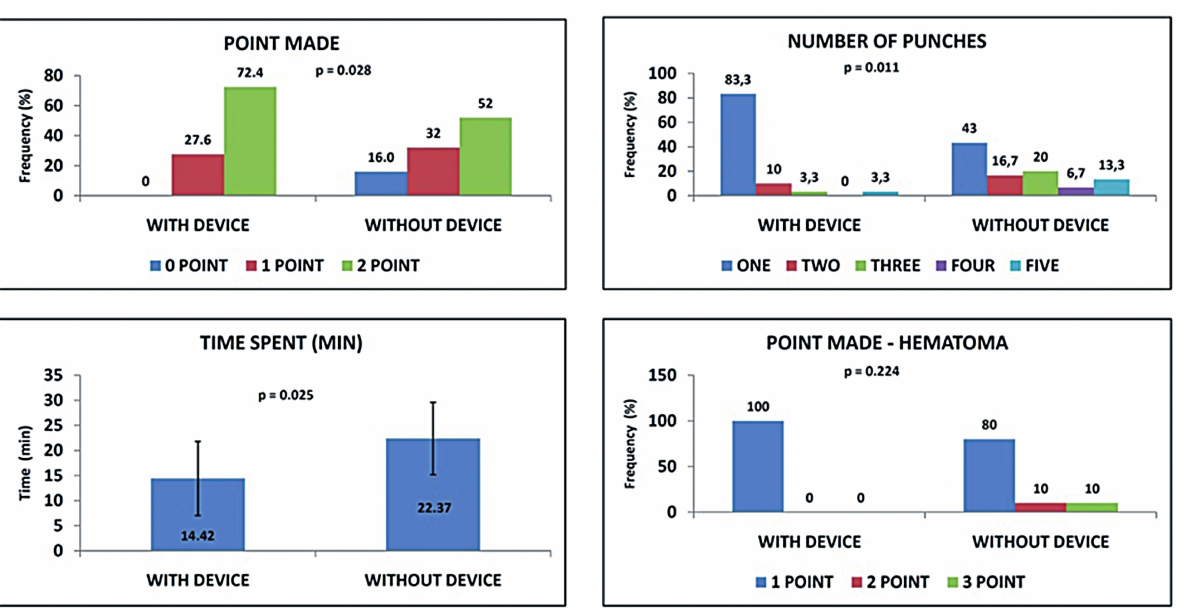
Table 1 - Results of the puncture procedures in the Punctiometer and no Punctiometer groups. Calyxes with a successful 1st puncture 25 (83%) Calyxes with a precision index rating of 2